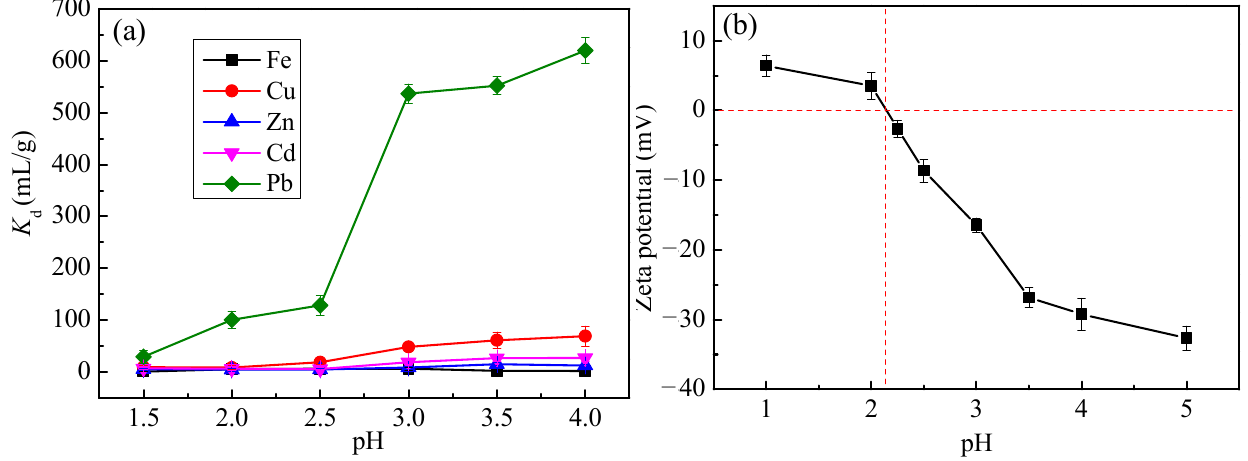
Figure 6. ( a ) Effect of pH on the adsorption of Pb(II) onto MT-WAO resin, ( b ) zeta potential of MT-WAO.